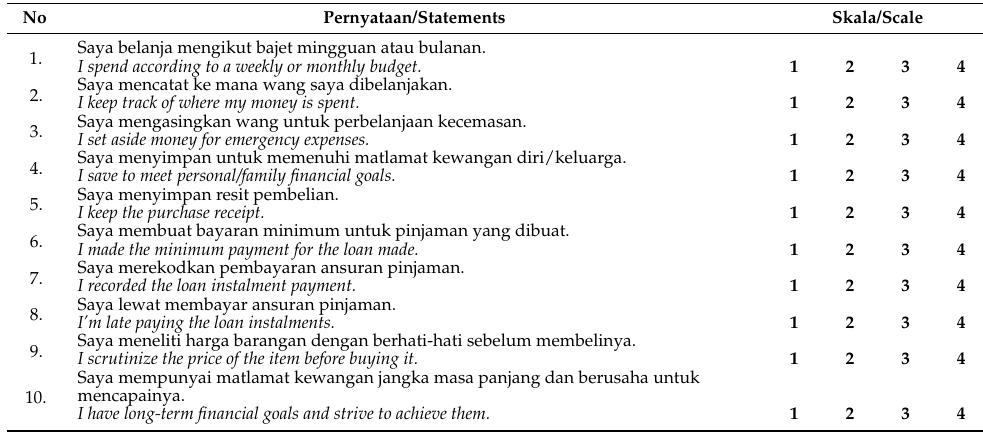
Table A1. Tidak Pernah/ Never Sangat Kerap/Selalu/